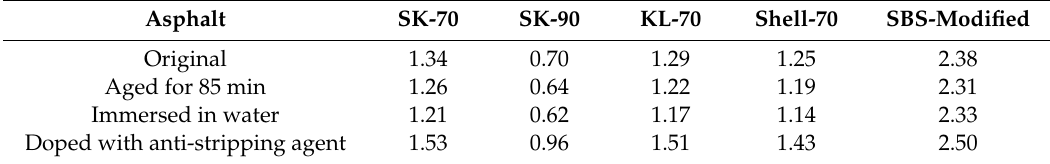
Table 8. Bonding coe ffi cients of the di ff erent asphalts’ bonding coe ffi cients